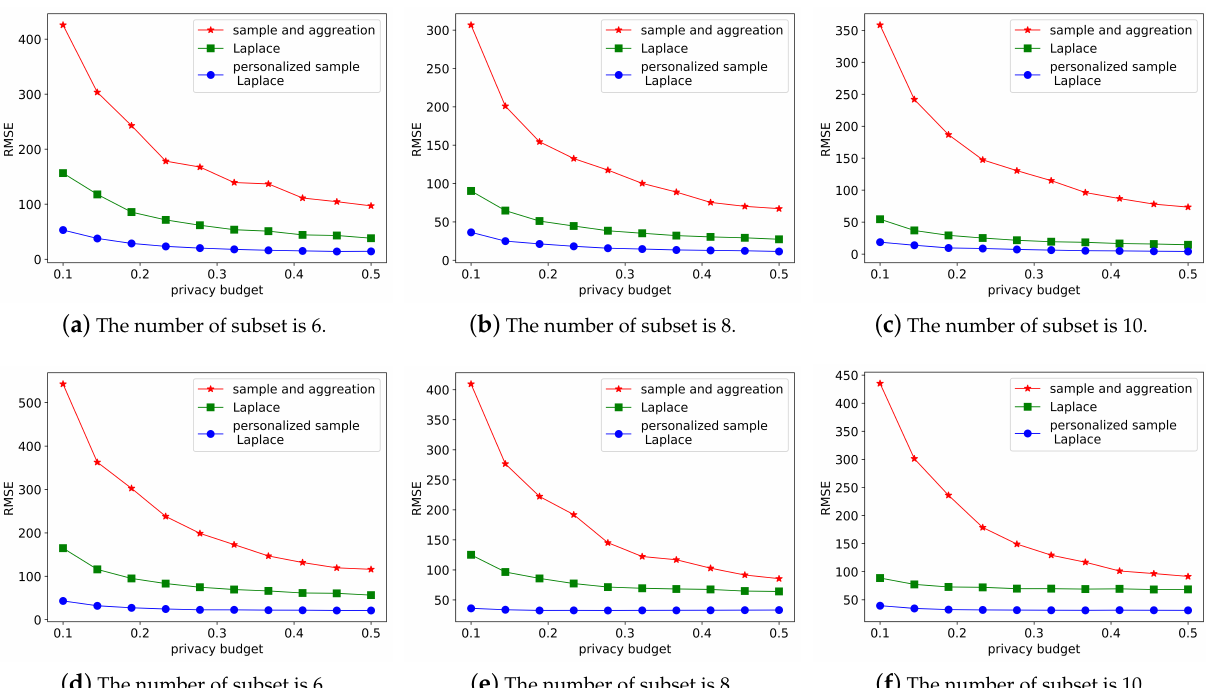
Figure 6. The influences of the number of subsets.